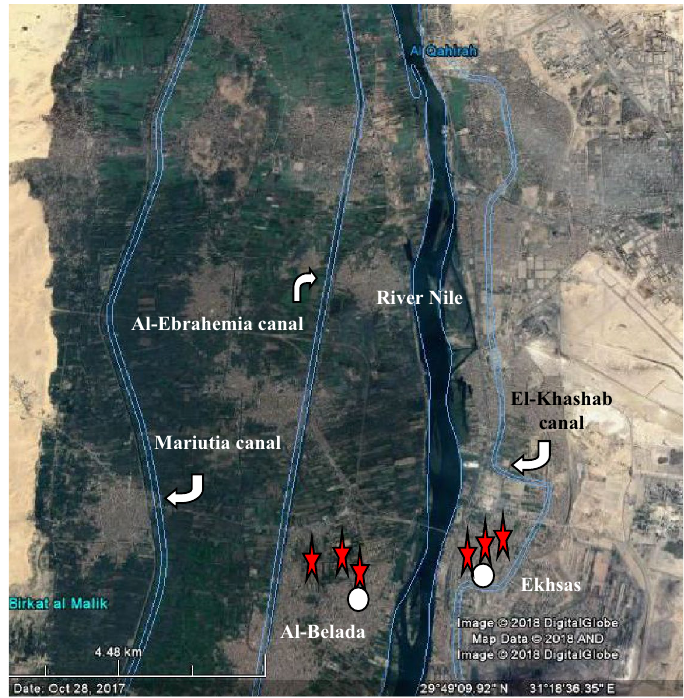
Figure 1. The study sites shown on a map of south Greater Cairo. 29° 49 ʹ 09.92 ʺ N and 31° 18 ʹ 36.35 ʺ